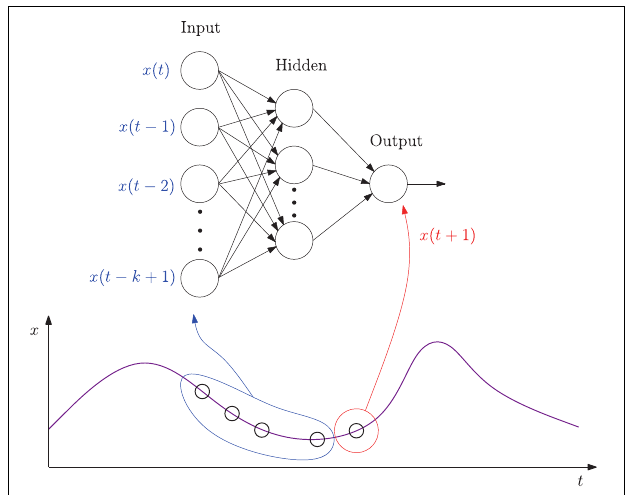
FIGURE 2 | A neural network predictor for time series data. A multi-layer neural network consisting of k = 10 input units, 10 hidden units, and one output unit was trained. The input values were taken from k consecutive values from a time series leading up to time t (time step t − k + 1 to t ), and the target output value set to the value at time step t + 1. The network is activated in a feed-forward manner, through the connections, and the error in the output vs. the target value back propagated to adjust the connection weights. See the text for more